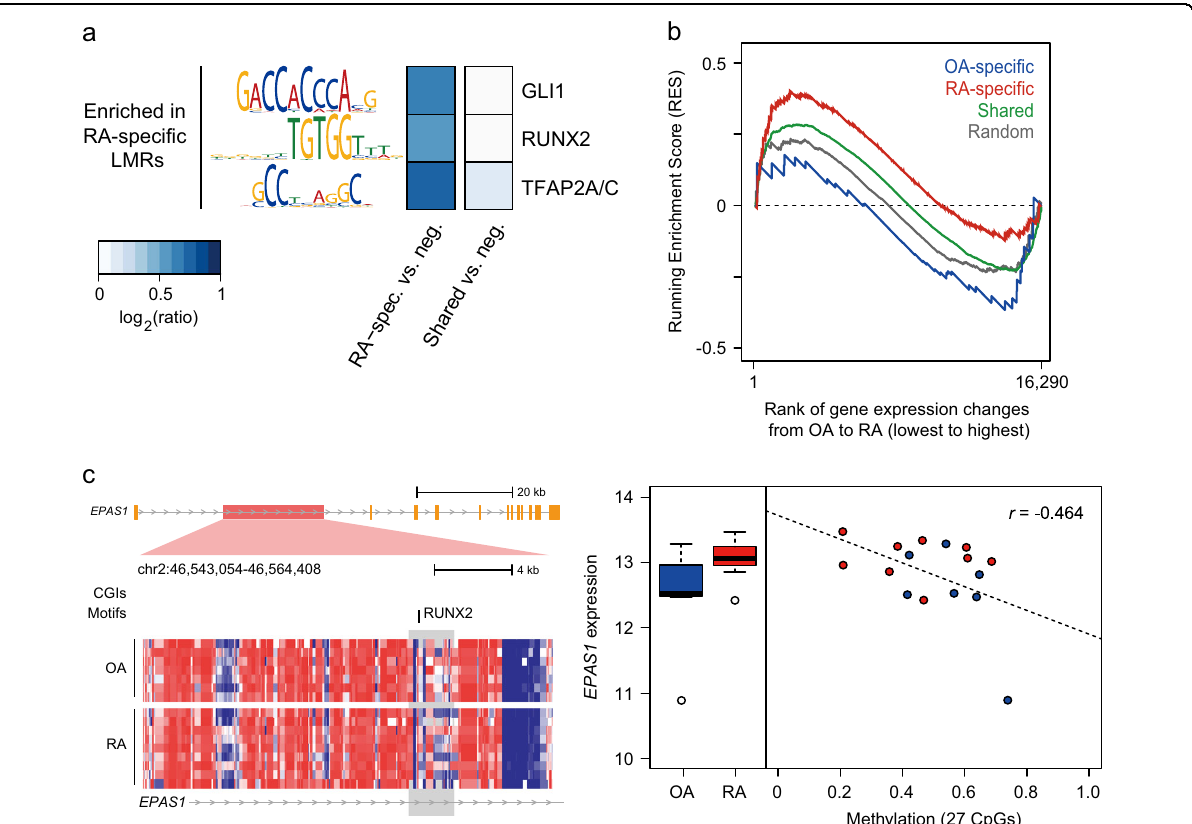
Fig. 3 Methylation in LMRs and expression of downstream targets. a A heatmap with enriched transcription factor binding motifs in LMRs. b A line plot showing the relationship between LMRs and downstream targets. LMRs speci fi c to a certain disease were highly enriched with the highly expressed genes in a certain disease. Downstream targets were chosen from genes with LMRs or were located within the downstream 5 kb from LMRs. Random represents permutated data. c An example of EPAS1 with an RA-speci fi c LMR. A left heatmap describes methylation in regions around an LMR. Methylation is colored from blue (low) to red (high). The LMRs are marked with a gray box. In the LMR, methylation is generally lower in RA than OA. A right plot depicts methylation in an LMR in each disease (left) and individual samples (right). Hypomethylation of the LMR is coupled with increased expression of this gene in RA (red) compared to OA (blue). RES Running Enrichment